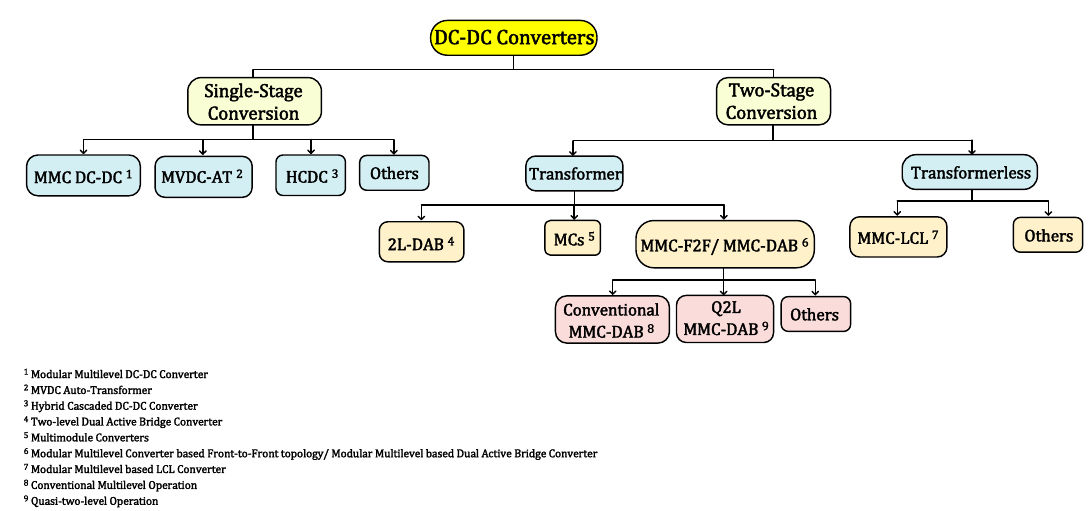
Figure 6. DC-DC converters classification based on the number of conversion stages.